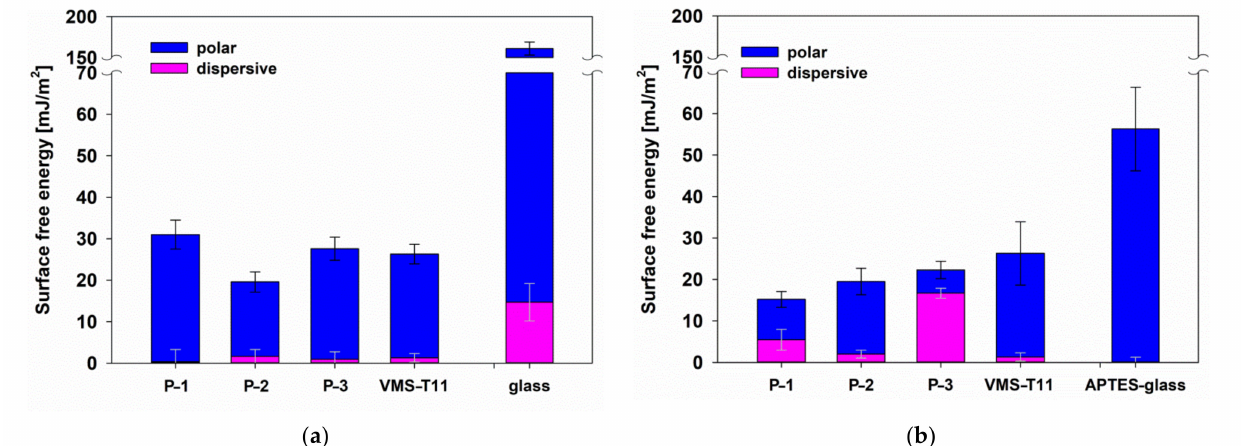
Figure 2. Surface free energy of functionalized polysiloxanes in comparison to their precursor VMS-T11 coated on ( a ) bare glass and ( b ) APTES-glass; (data presented as the mean ± standard deviation (SD, n =